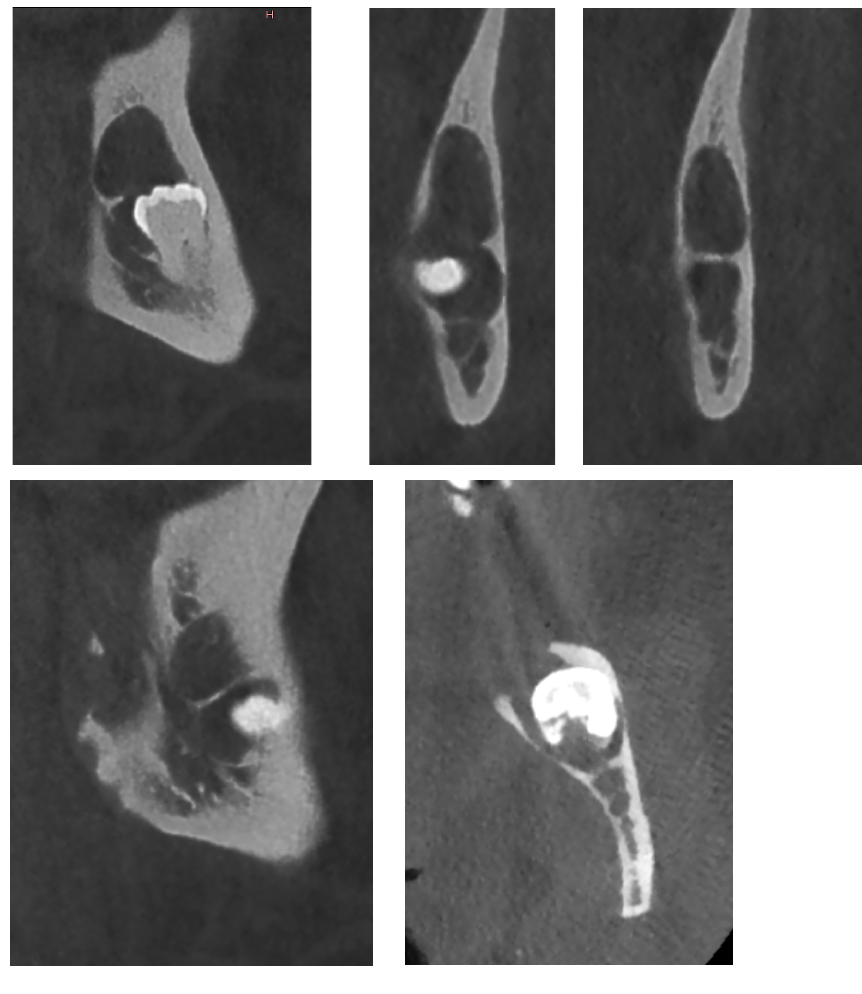
Figure 11. CBCT X-ray of case #4.